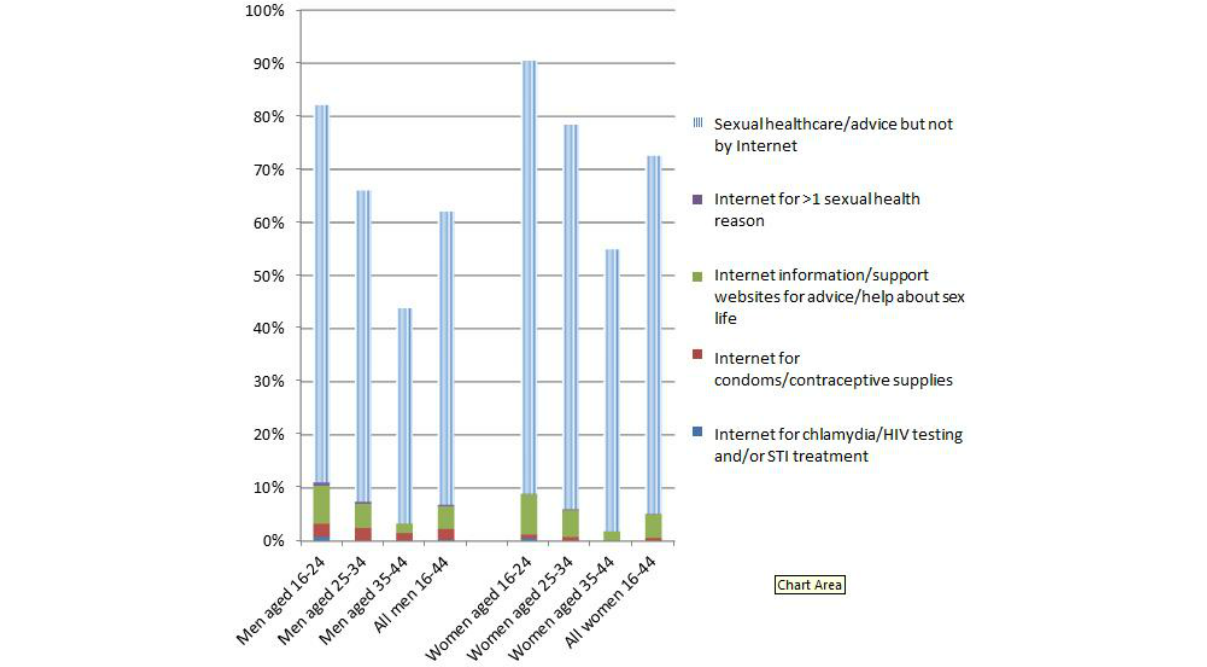
Figure 1. Percentage reporting seeking sexual health care and advice/help with one’s sex life in the previous year, and specifically using the Internet to do so, among sexually experienced persons aged 16-44 years by gender and age